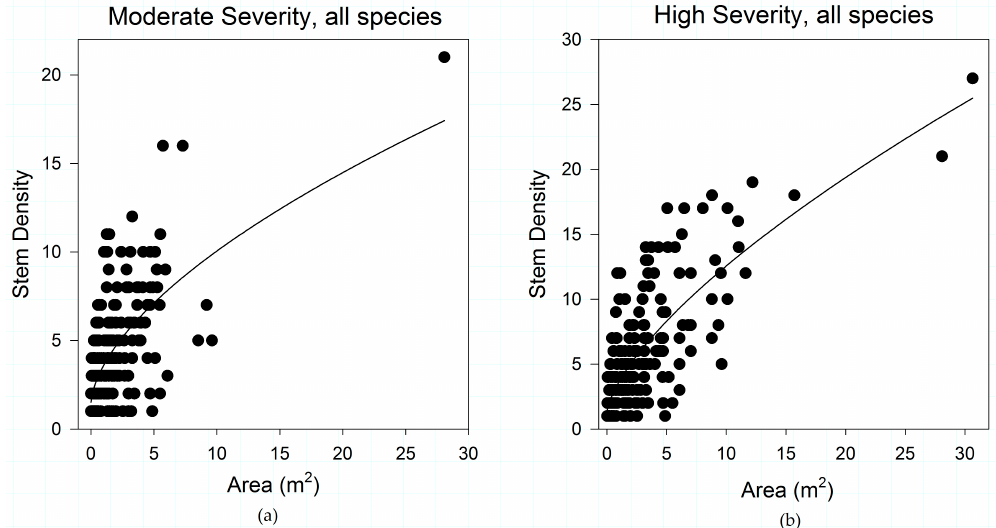
Figure 5. ( a ) Shrub patch structural relationships for moderate-severity fire; and ( b ) Shrub patch structural relationships for high-severity fire, in the study area. Fire severity has an organizing effect on shrub patch structure. Increases in fire severity show a strengthening in the relationship between shrub canopy area and stem